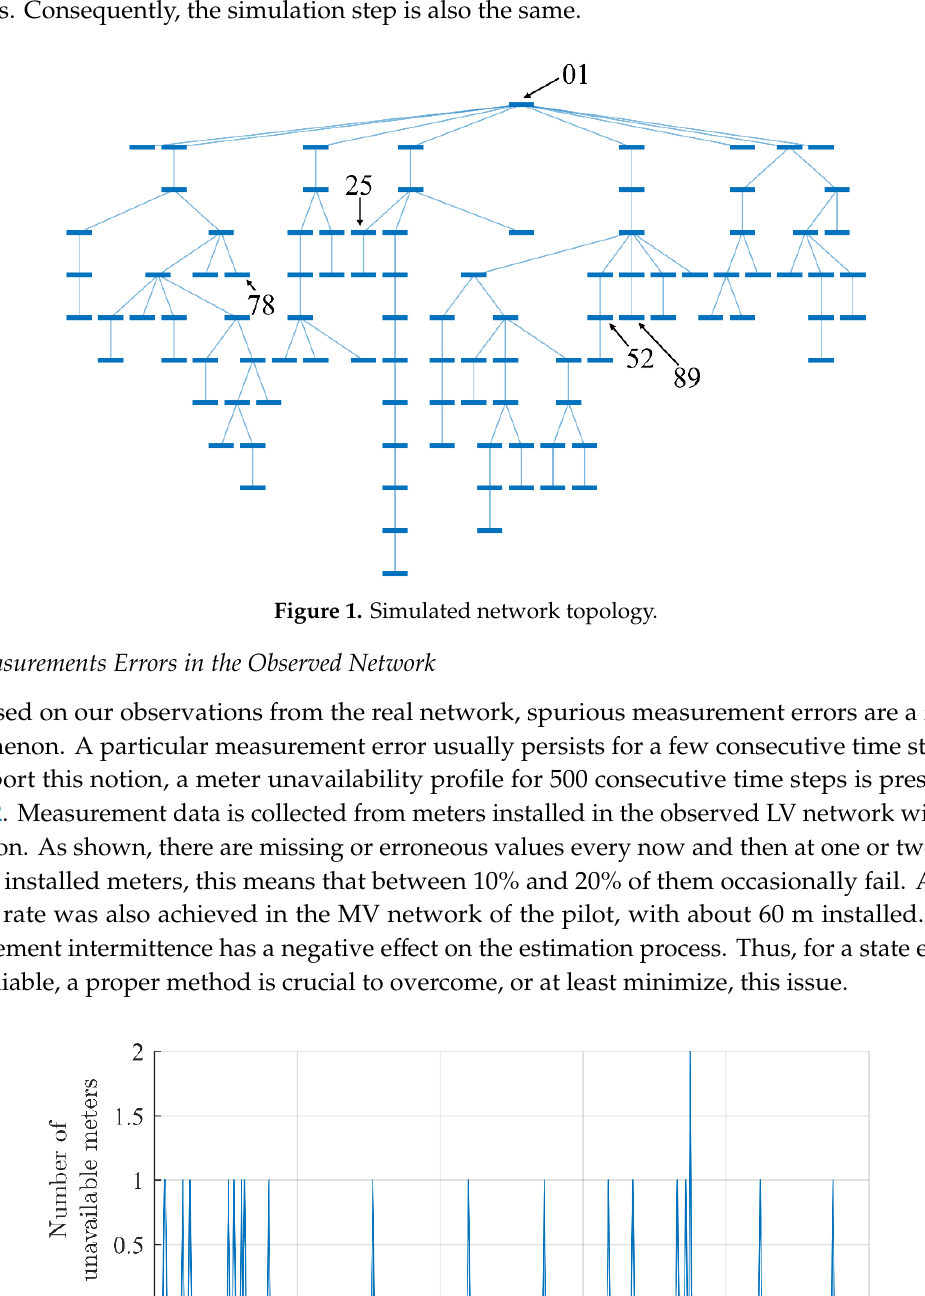
Figure 2. Network meter unavailability vs. time.